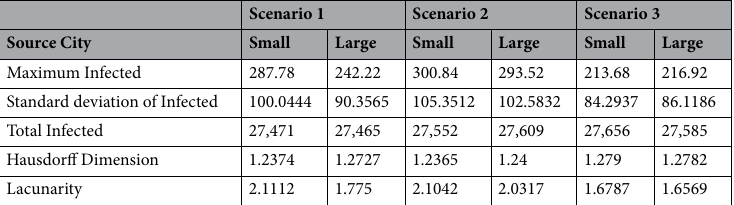
Table 3. Numerical results of